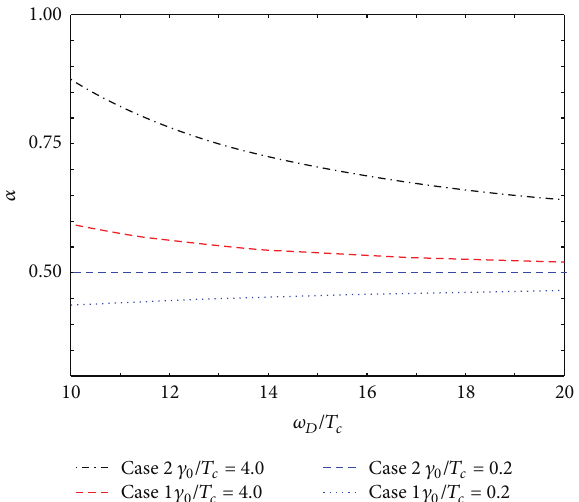
Figure 1: The 𝑇 𝑐 versus hybridization coefficients of Cases 1 and 2.